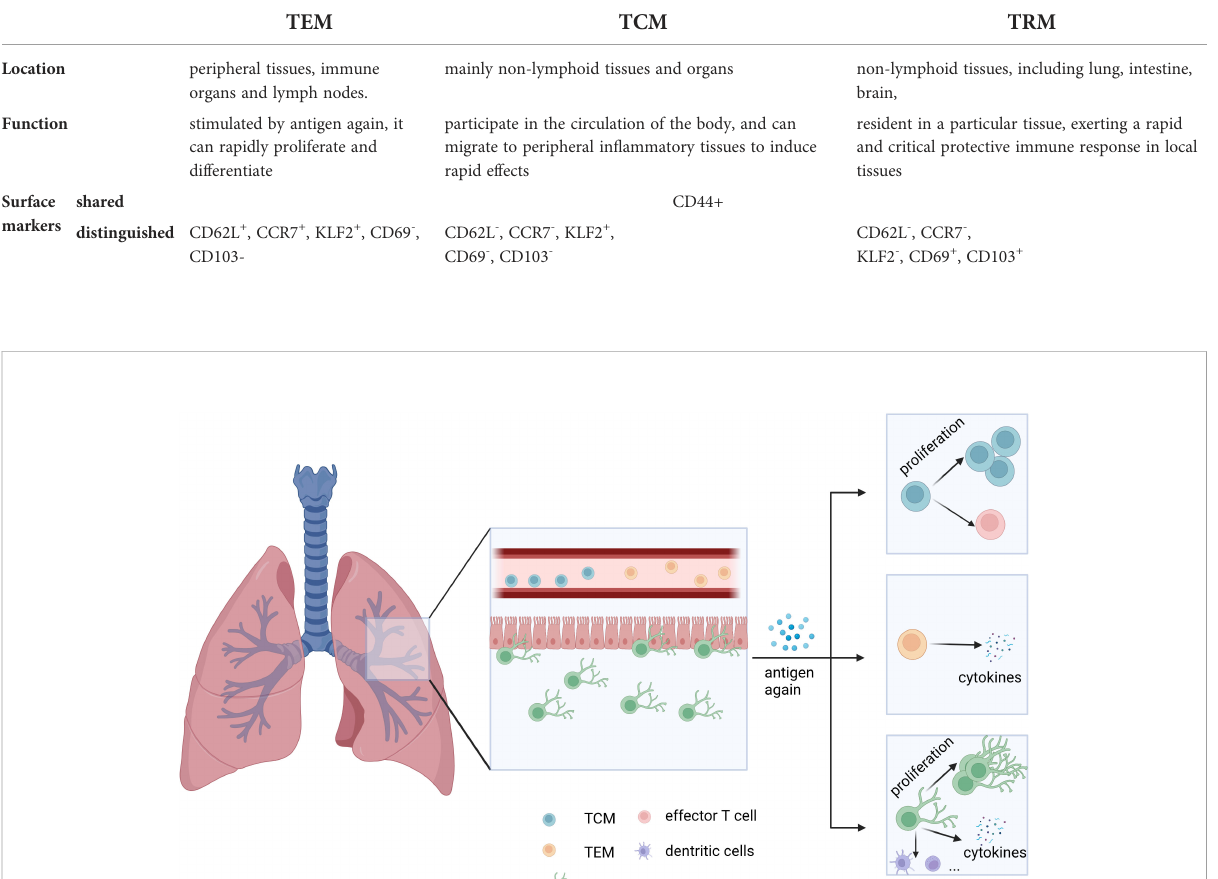
TABLE 1 basic traits of effector memory T cells, central memory T cells and resident memory T cells. TEM TCM TRM Location peripheral tissues, immune organs and lymph nodes.